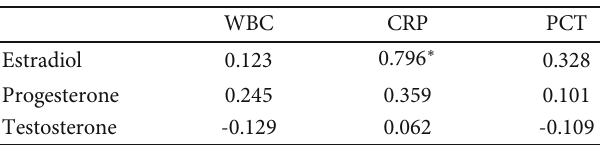
Figure 2: Receiver operating characteristic (ROC) curves of hormone levels, age, APACHE II, and SOFA scores for AKI in patients with MSAP and SAP. Note: APACHE II: Acute Physiology and Chronic Health Evaluation II; SOFA: sequential organ failure assessment; AKI: acute kidney injury; MSAP: moderately severe acute pancreatitis; SAP: severe acute pancreatitis. Table 5: Correlation coe ffi cient analysis of serum hormones and the selected